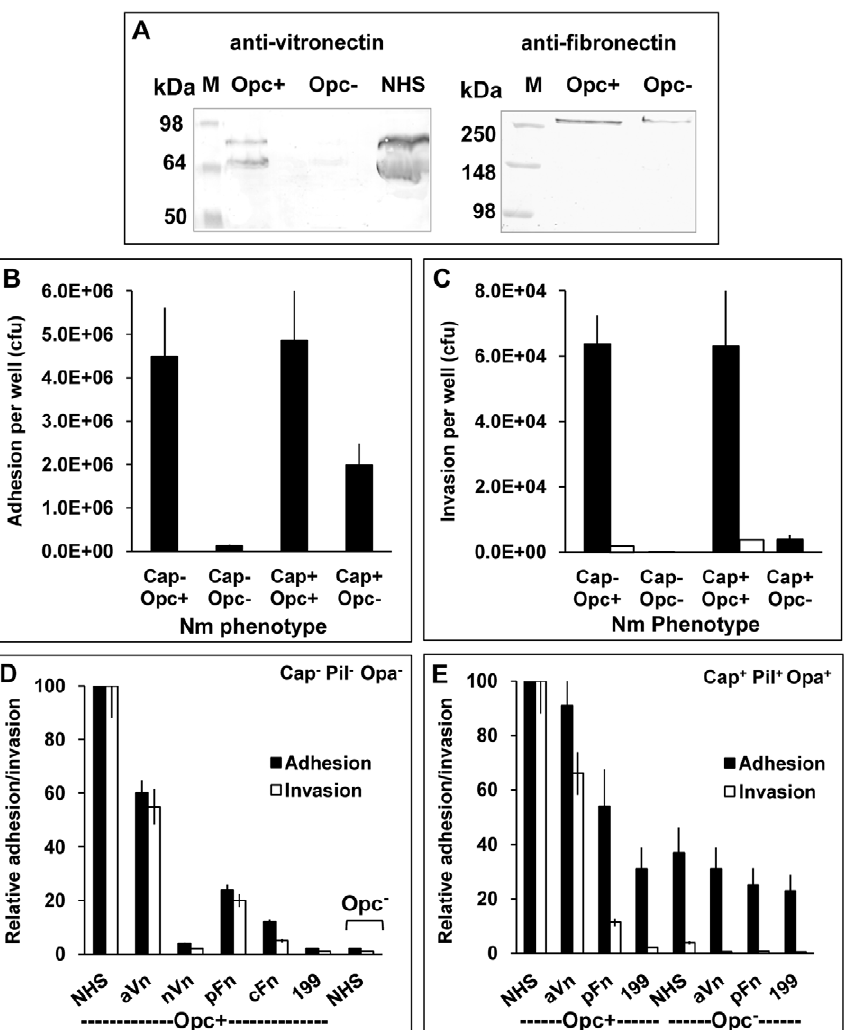
Figure 1. Invasion of HBMECs by capsulate and acapsulate meningococci is dependent on Opc-expression and serum components. (A) To determine the relative binding of the serum proteins to Opc + and Opc 2 N. meningitidis , bacteria were incubated with 10% normal human serum (NHS). The binding of vitronectin (Vn) and fibronectin (Fn) was assessed by applying lysates of serum coated, washed bacteria to SDS- polyacrylamide gels and western blotting. Anti-Vn and anti-Fn antibodies followed by AP-conjugated secondary antibodies were used to detect the proteins. Opc-expressing Nm bound to Vn and Fn, whereas Opc-deficient bacteria bound considerably weakly to the proteins. Lane marked NHS was loaded with the serum sample. The two vitronectin bands shown in the left blot correspond to the two molecular forms of vitronectin (75 and 65 kDa) found in human blood, the lower molecular form results from endogenous cleavage of a small region at the C-terminal end of some Vn molecules (see reference 26). (B, C) Relative efficiencies of Opc + and Opc 2 Nm isolates of strain C751 and MC58 (without or with capsule, pili and Opa expression respectively) in mediating HBMEC adhesion and invasion in serum supplemented media were determined by viable count and gentamicin protection assays. To confirm that gentamicin-resistant bacteria were truly internalised, cytochalasin D (CD) was used in some tests to prevent bacterial uptake into cells. In this case, no bacteria survived the gentamicin treatment (invasion levels indicated by blank columns in C) [35]. (D, E) In similar experiments, various purified serum components were compared with NHS in their ability to support HBMEC adhesion and invasion by acapsulate and capsulate meningococci. When supplemented, the infection media contained 10% NHS or 10 m g/ml of one of the following serum proteins: activated Vn (aVn), native Vn (nVn), cellular Fn (cFn) and plasma Fn (pFn), as in preliminary experiments, these were found to be the optimum concentrations required. The most effective serum component was found to be aVn in enhancing both cellular adhesion as well as invasion. Plasma Fn also supported adhesion and invasion but to a significantly lesser extent (D and